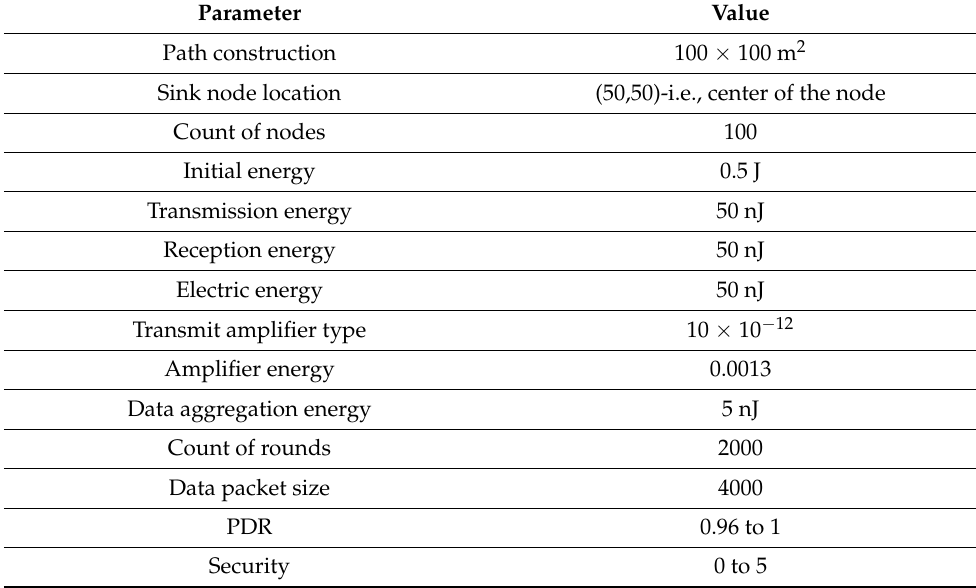
Table 3. Simulation